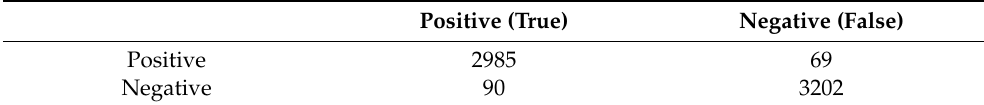
Table 2. Confusion matrix of the proposed method.